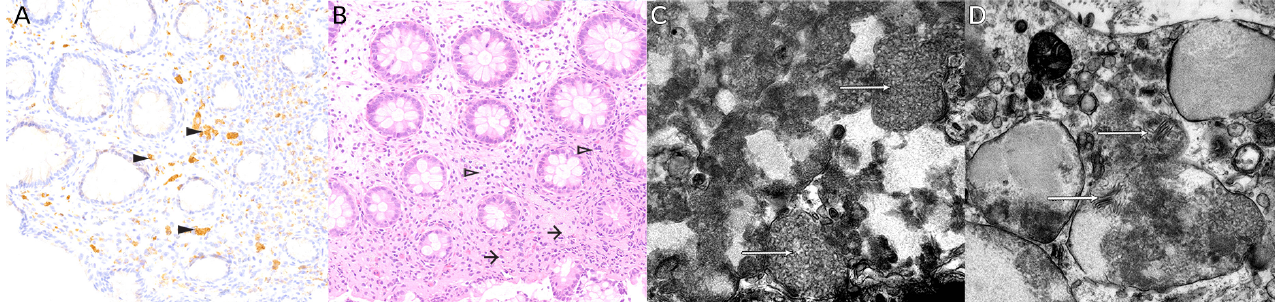
Figure 2. ( A ) Increased number of CD68 positive interstitial macrophages loaded with lipofuscin within colorectal mucosal biopsy (black arrowheads). Original magnification 200 × . ( B ) Colorectal mucosa biopsy showing an increased number of interstitial macrophages (arrows) and a slightly increased amount of eosinophilic stroma of the lamina propria (hollow arrowheads). Original magnification 200 × . Electron micrograph shows the biopsy of the rectal mucosa with the abnormal deposits in the epithelial cells and macrophages presenting as ( C ) the curvilinear profiles (white arrows), and ( D ) the fingerprint profiles (white arrows). Original magnification 105,000 ×